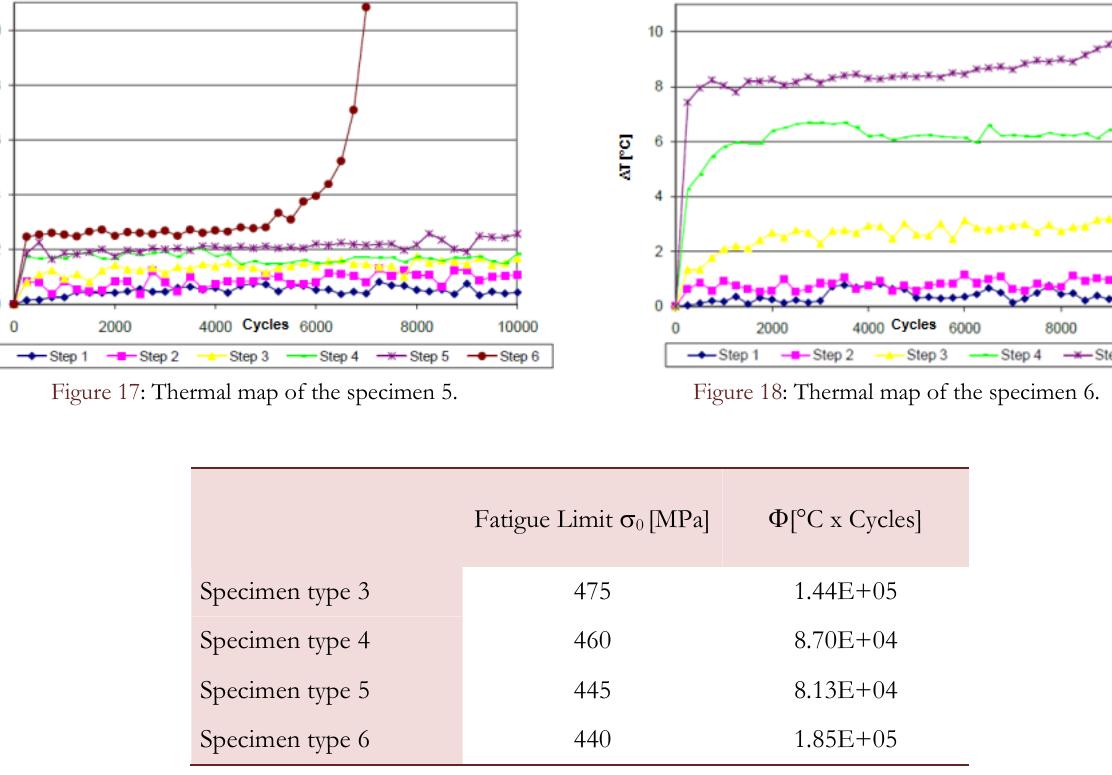
Table 8: Results data of fatigue test.